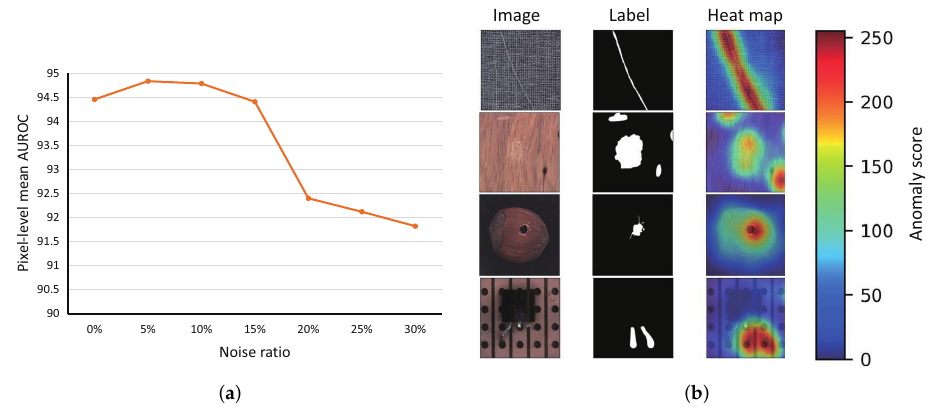
Figure 10. ( a ) Pixel-level mean AUROC at different noise ratios. ( b ) Segmentation result at a noise ratio of 15%.